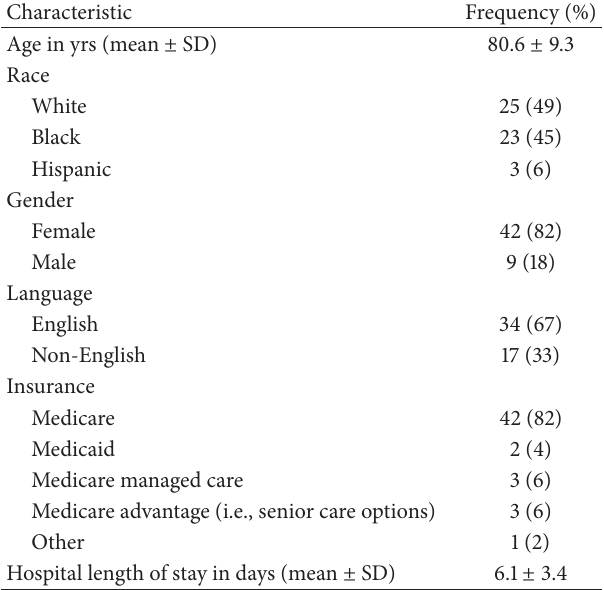
Table 1: Baseline characteristics of the study sample ( 𝑁 = 51 ). Table 2: Categories of recommendations made by the hospital discharging team.